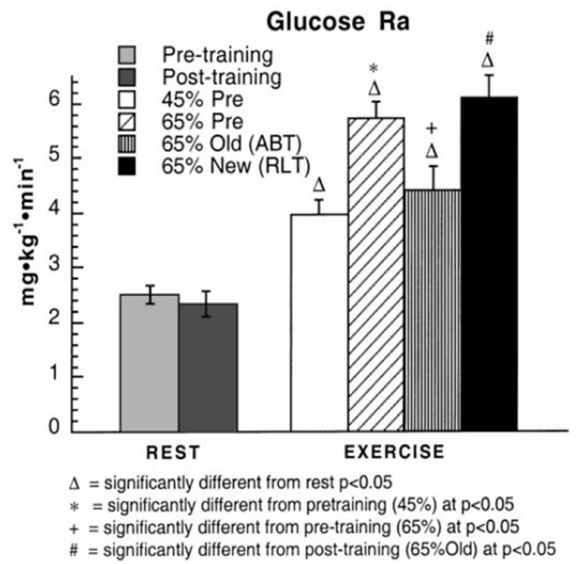
Figure 3. Blood glucose appearance rates (Ra), or flux in healthy young men during rest and exercise, before and after training. Subjects were studied at 45 and 65% of peak rate of oxygen consumption (VO 2 peak) before 9 week of endurance training (45% pre and 65% pre, respectively) and then after training at same absolute power output that elicited 65% VO 2 peak before training (65% old (absolute, ABT)) and same relative power output that elicited 65% VO 2 peak after training (65% new (relative, RLT)). Values are means ± SE; n = 8–9. Note that compared to rest, exercise increases tracer-measured blood glucose rate of appearance 2–3 times. Comparing the second and third columns on the right in which men exercised at the same exercise power output before and after training, glucose Ra and Rd (not shown) decreased with training. However, the greatest glucose Ra was observed during hard, 65% VO 2 max exercise after training (last column). From